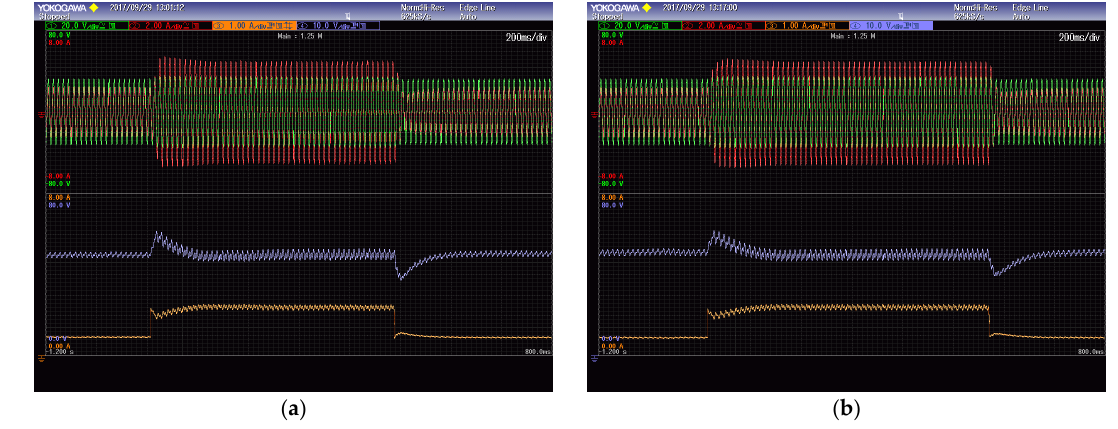
Figure 20. Experimental results of modified RCC-MPPT algorithms in the case of step transients of R S : ( a ) using only the second harmonic component (100 Hz); and ( b ) using only the first harmonic component (50 Hz). Top traces: grid voltage and current. Bottom traces: PV voltage and current.